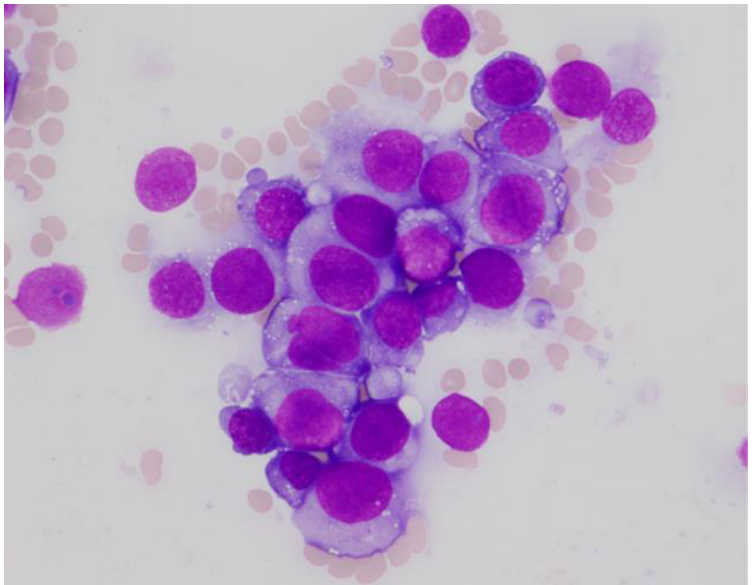
Figure 1. Bone marrow smears on admission (May-Giemsa staining, × 400). A majority of the nucleated cells were medium- to large-sized abnormal cells. Abnormal cells had condensed chromatinated nuclei and distinct nucleoli, with basophilic cytoplasm with cytoplasmic blebs and vacuoles. PEL was one of the differential diagnoses at this point; however, the abnormal cells also showed aggregation and cell–cell adhesion, suggesting the possibility of epithelial cancer metastasis. There were no blast cells or abnormal cells found in peripheral blood, and osteolytic changes in the sacrum and ilium further supported this possibility. Therefore, we searched for a primary cancer while we waited for the result of the bone marrow biopsy and its immunohistochemistry. No remarkable lesions were found in the upper and lower gastrointestinal endoscopy. Fluorodeoxyglucose-positron emission tomography (FDG-PET) demonstrated a high level of accumulation in the femur, sacrum and ilium (Figure